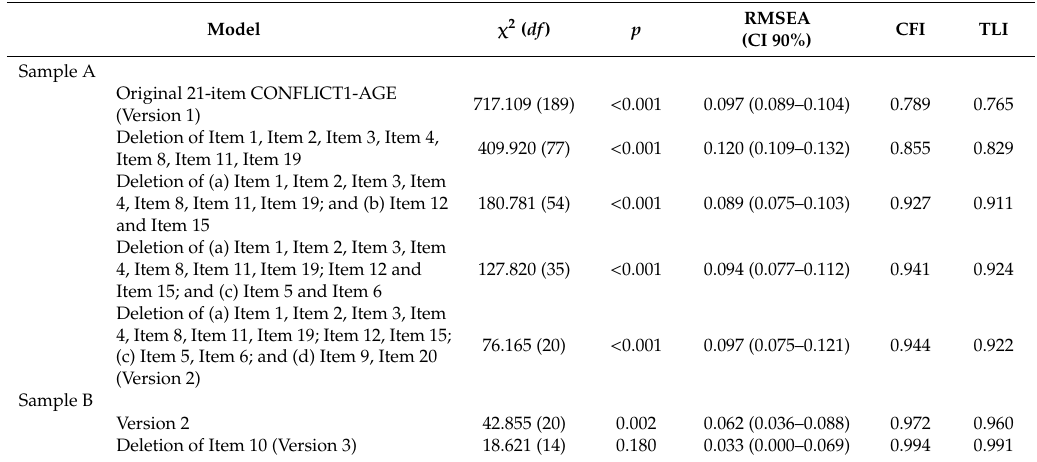
Table 1. Comparison among CFA (Confirmatory factor analysis) measurement models